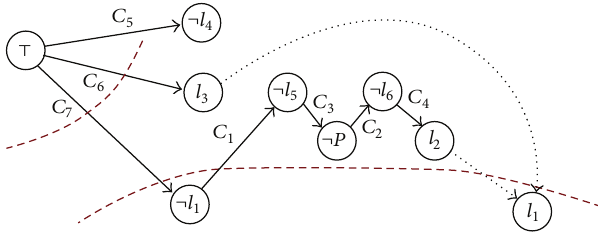
Figure 5: The implication graph in steps 11 and